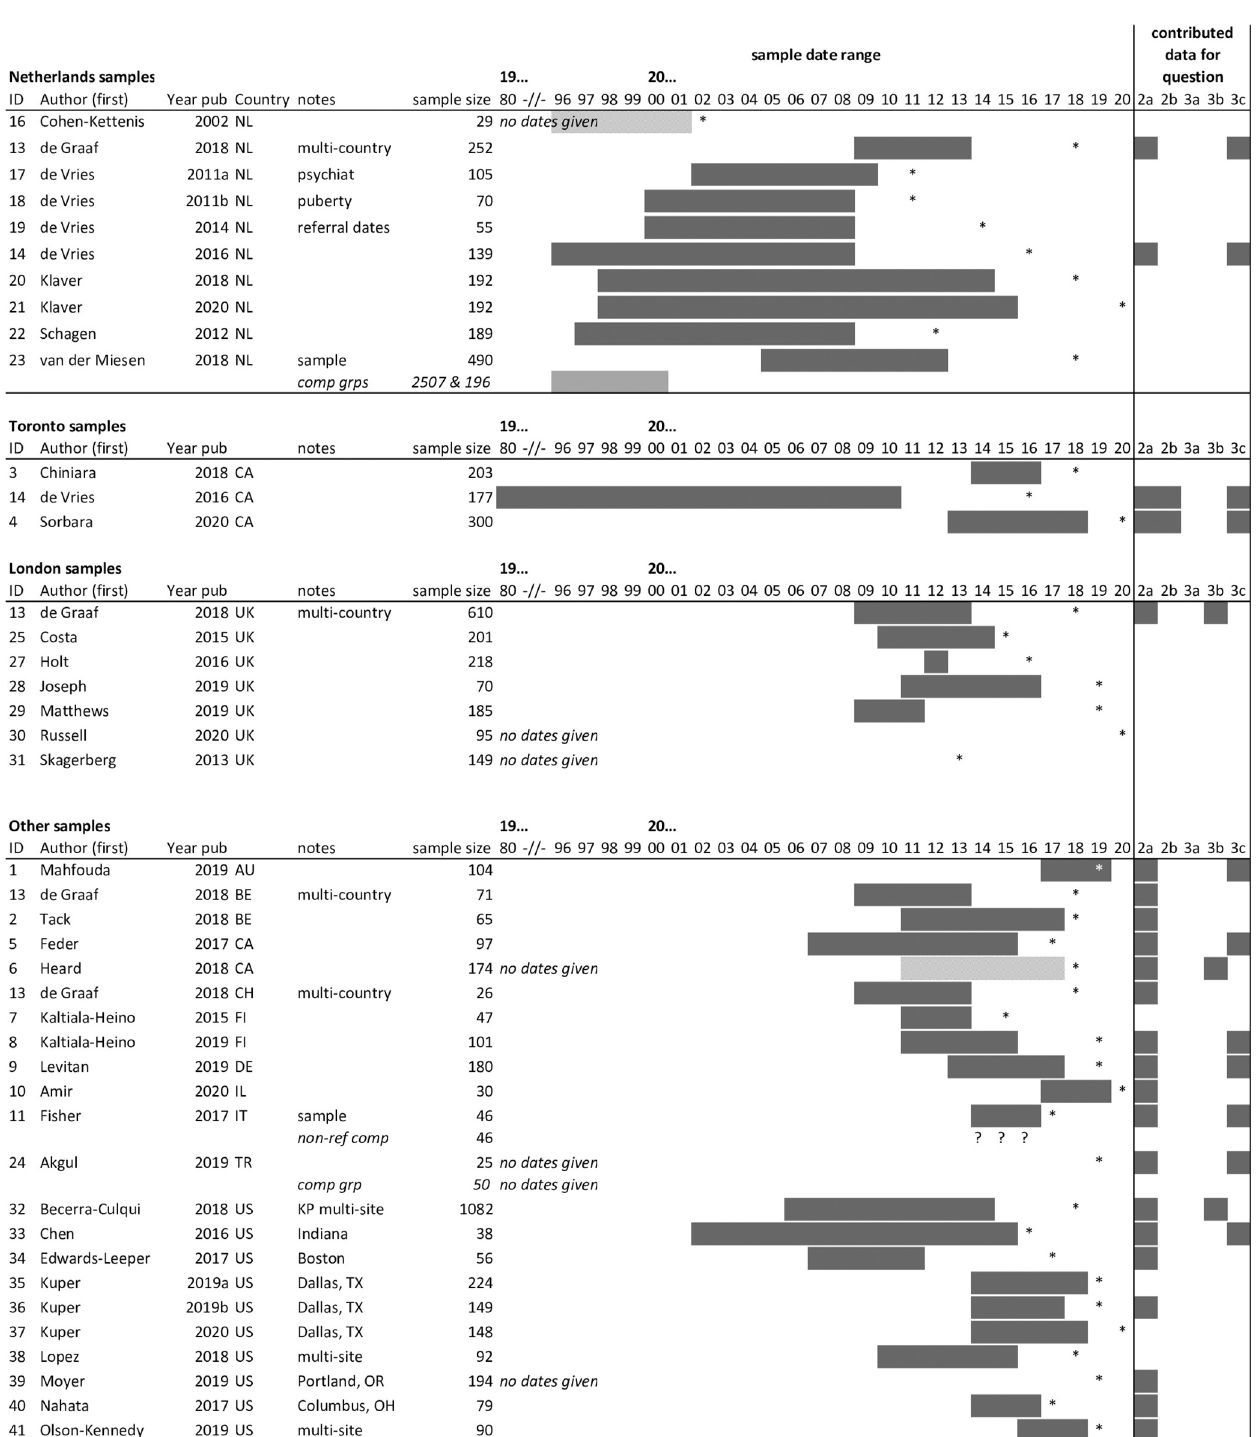
Fig 2. Overlap between included samples. Key -//-: dates truncated; � : year of publication; NL: Netherlands; CA: Canada; UK: United Kingdom; AU: Australia; BE: Belgium; FI: Finland; DE: Germany; IL: Israel; IT: Italy; CH: Switzerland; TR: Turkey; US: United States.